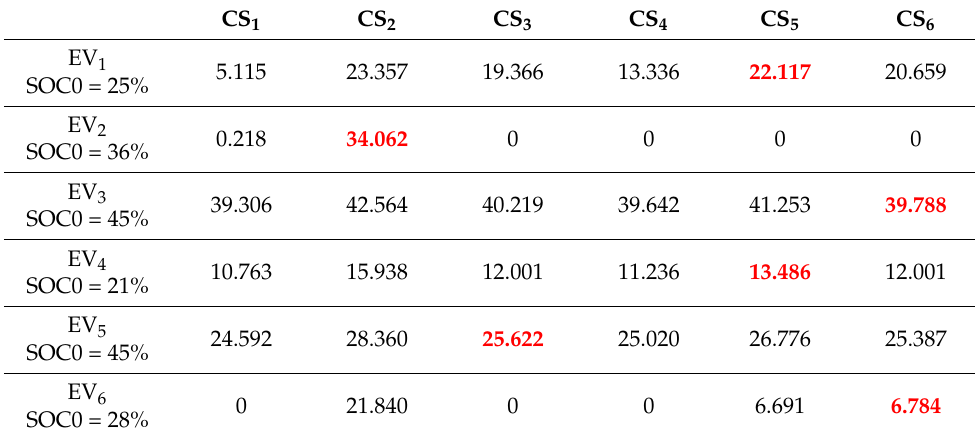
Table 2. Optimal values of SOC f for each EV.